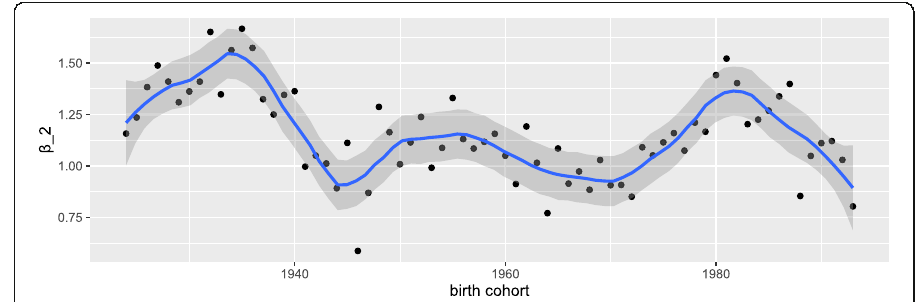
Fig. 3 Yearly variation in the effect of hukou on respondents ’ years of